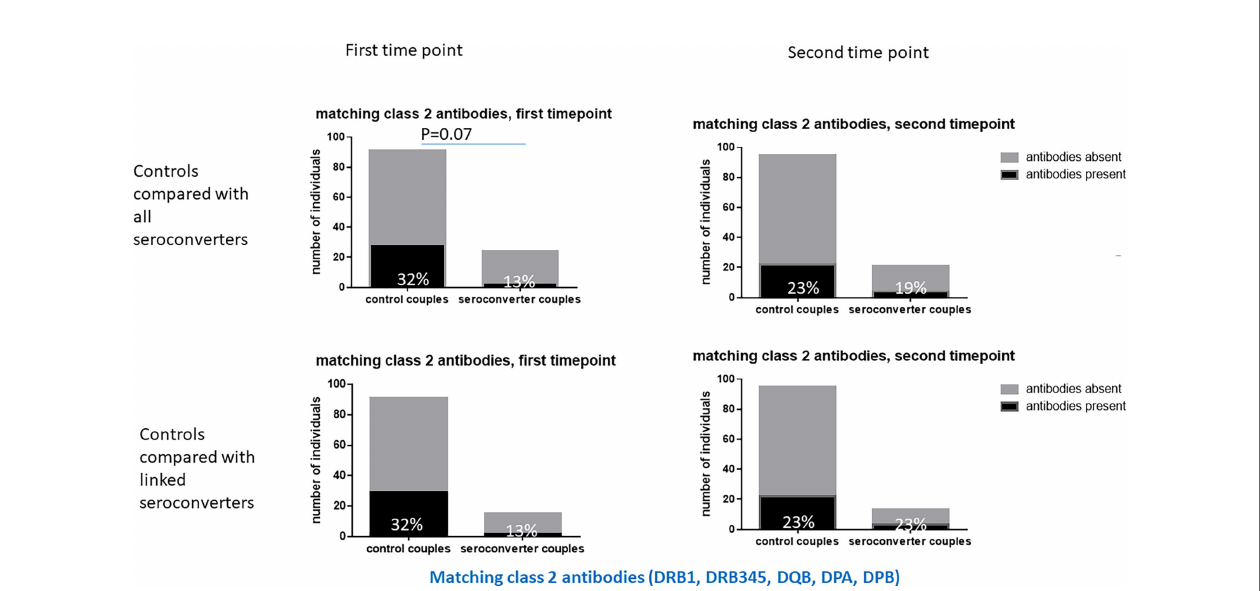
FIGURE 3 | Matching class 2 HLA antibodies in HIV-seroconverters compared with highly exposed persistently seronegative controls, at the fi rst and second timepoints. Upper panel shows comparison of highly exposed persistently seronegative controls with all HIV-seroconverter couples. Lower panel shows comparison of highly exposed persistently seronegative controls with only linked HIV-seroconverter couples. At the fi rst timepoint there was a trend to more matching class 2 HLA antibodies in highly exposed persistently seronegative controls than in those who went on to acquire HIV.